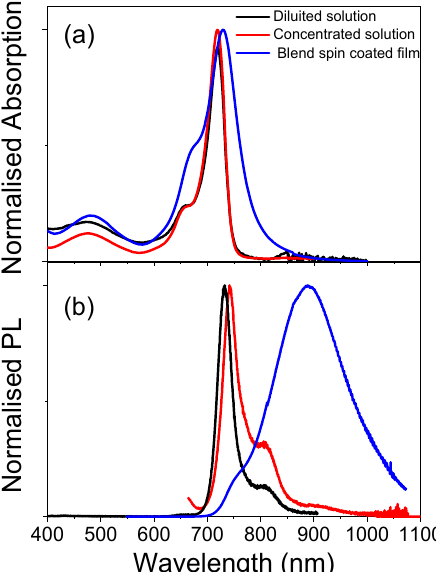
Figure 2. ( a ) Absorption spectra. ( b ) Photoluminescence spectra. Diluted solution (black line), concentrated solution (red line), and spin-coated film using the blend 10% dye in the Polystyrene matrix (blue line).